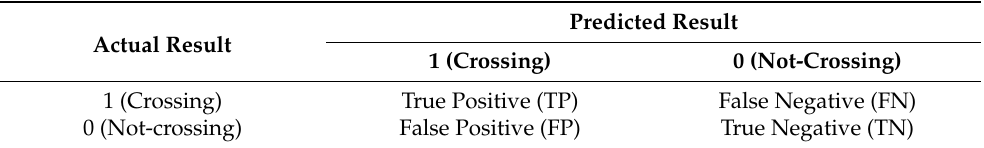
Table 2. Outcomes of a binary classification problem.